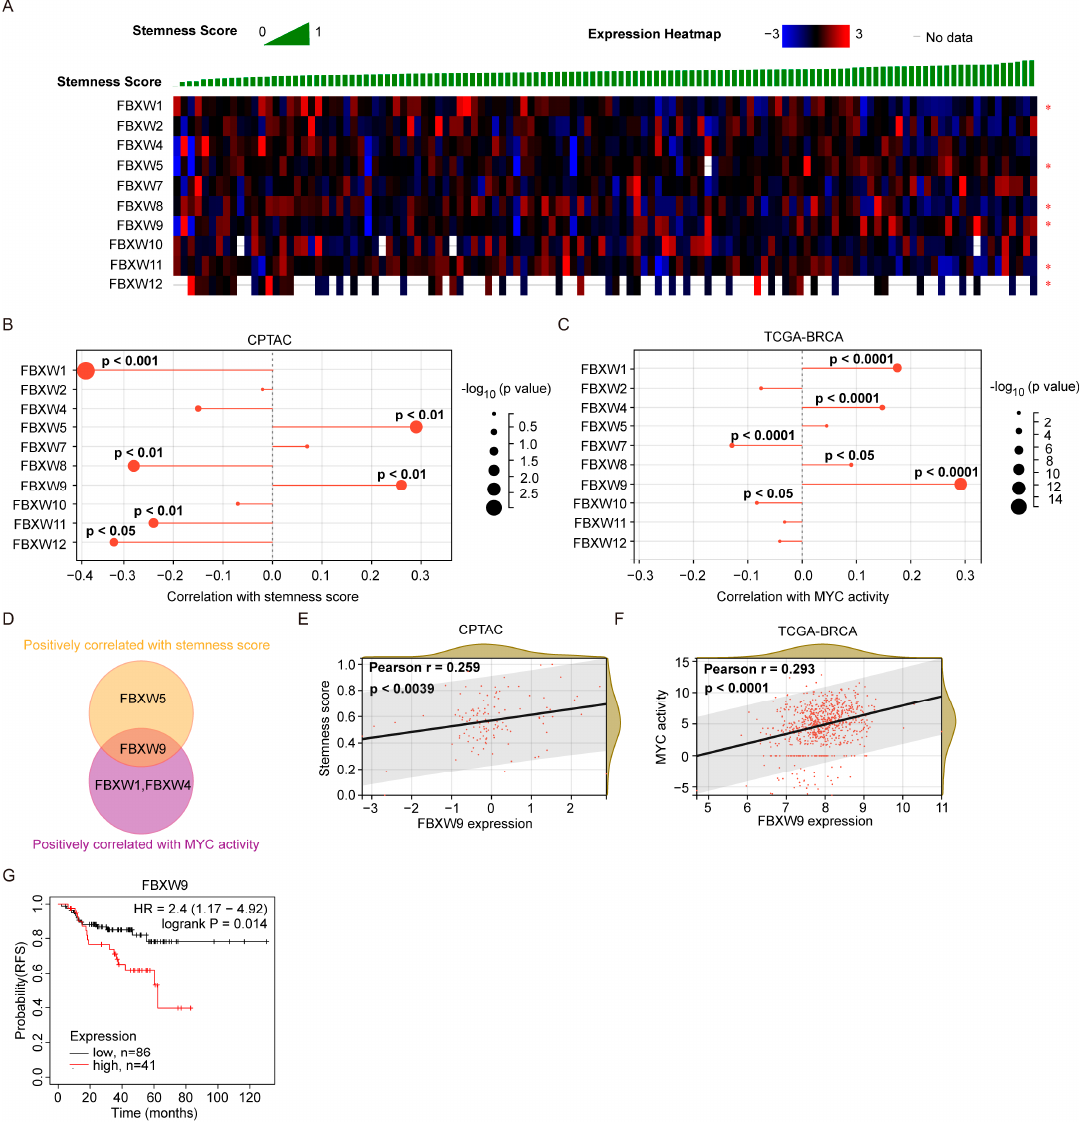
Figure 5. Analysis of the association between expression of FBXWs and stemness in breast cancer. ( A , B ) The association between the expression of FBXWs and stemness score was explored in the CPTAC dataset. ( C ) The association between the expression of FBXWs and MYC activity was ex- plored in the TCGA-BRCA dataset. ( D ) Venn diagram analysis of FBXWs associated with stemness